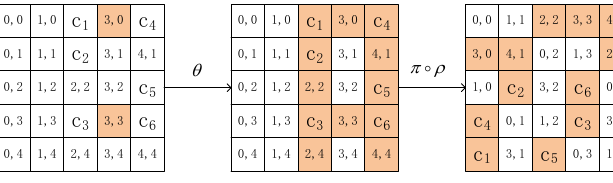
Figure 9: Diffusion of the 32-bit Keys in A [3 , 0], A [3 , 3] and 64-dimension